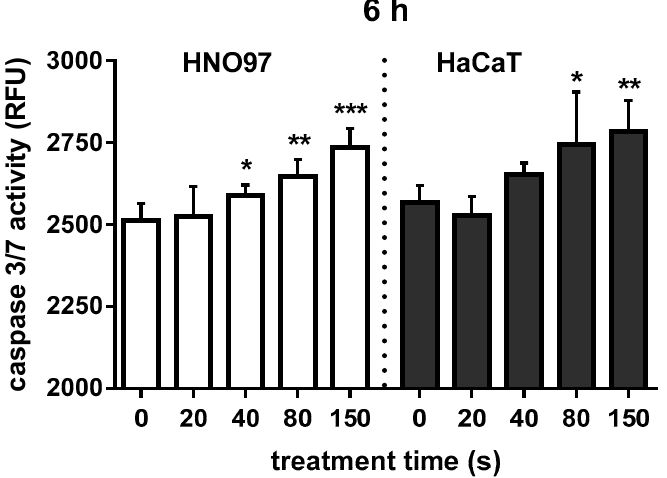
Figure 3. Activation of caspase 3 / 7 by CAP treated cell culture medium in HaCaT keratinocytes and HNO97 cells. CAP treatment took place for 0, 20, 40, 80 and 150 s and incubation followed for 6 h. Activation is detected as relative fluorescent units (RFU). Each bar resulted of three individual measurements (mean +SD).